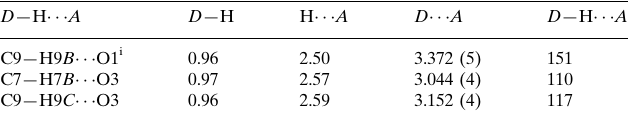
Hydrogen-bond geometry (A˚ , (cid:1)